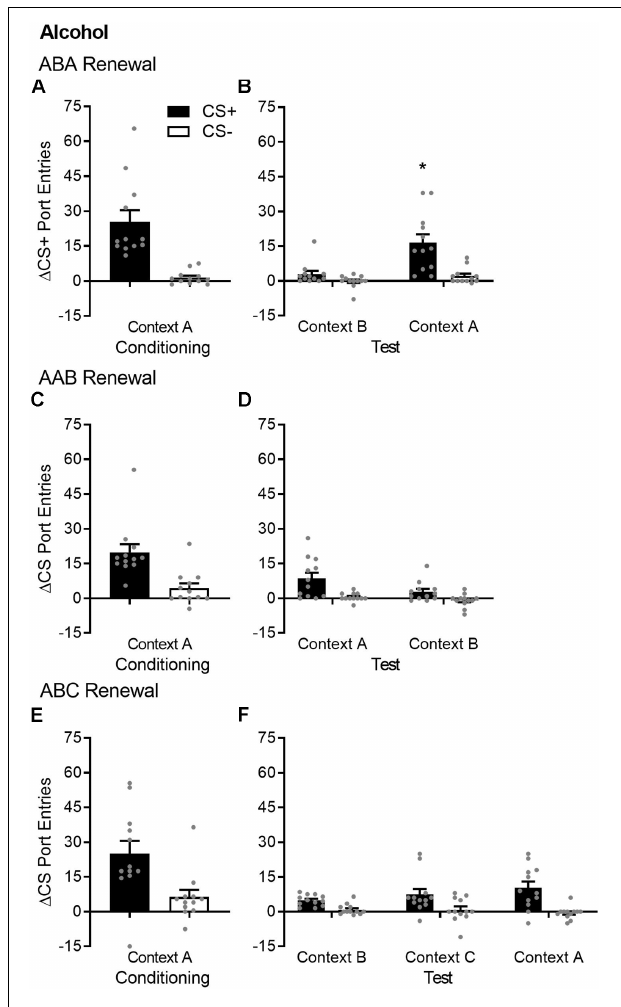
FIGURE 1 | ABA but not AAB or ABC renewal of Pavlovian conditioned responding in alcohol-trained rats. (A,C,E) Average port entries during the CS+ (black bars) and CS– (white bars) across the final session of Pavlovian discrimination training and retraining in context A in the ABA, AAB, and ABC renewal experiments. In all cases, CS+ port entries were significantly higher than CS– port entries. (B) In the ABA renewal experiment, CS+ port entries at test in context A were significantly elevated compared to the control test in context B. (D) In the AAB renewal experiment, overall CS port entries were significantly lower at test in context B, relative to the control test in context A. (F) In the ABC renewal experiment, there was no significant difference in responding during either CS across an extinction baseline in context B (averaged across the final session of extinction and re-extinction) and renewal tests in context C or A. All data are mean ± SEM (cid:49) CS port entries (CS minus pre-CS). n = 12 per experiment. Data from individual rats are overlaid